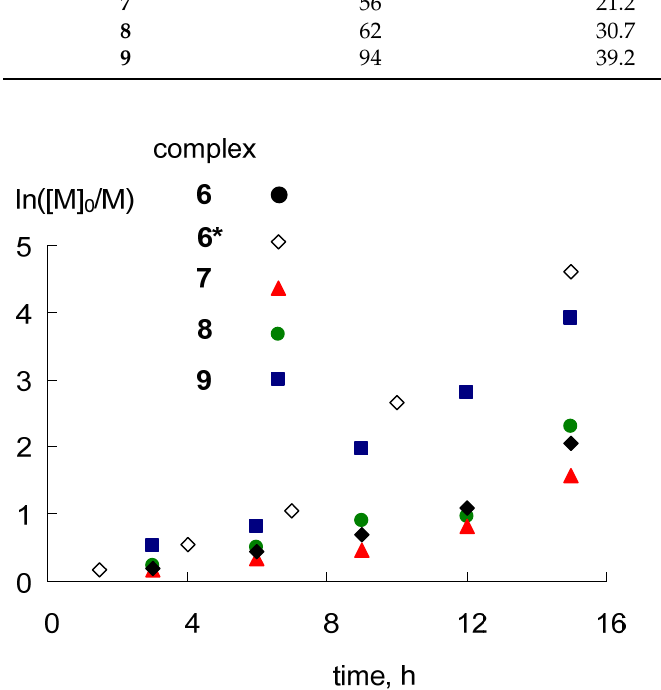
Figure 7. The dependences of ln[M] 0 /[M] versus time for polymerization of MMA in the presence of ruthenacarboranes 6 – 9 at 80 °C. [ ММА ]: [CCl 4 ]: [Ru]: [i-PrNH 2 ] = 10000: 25: 1: 40. *—[ ММА